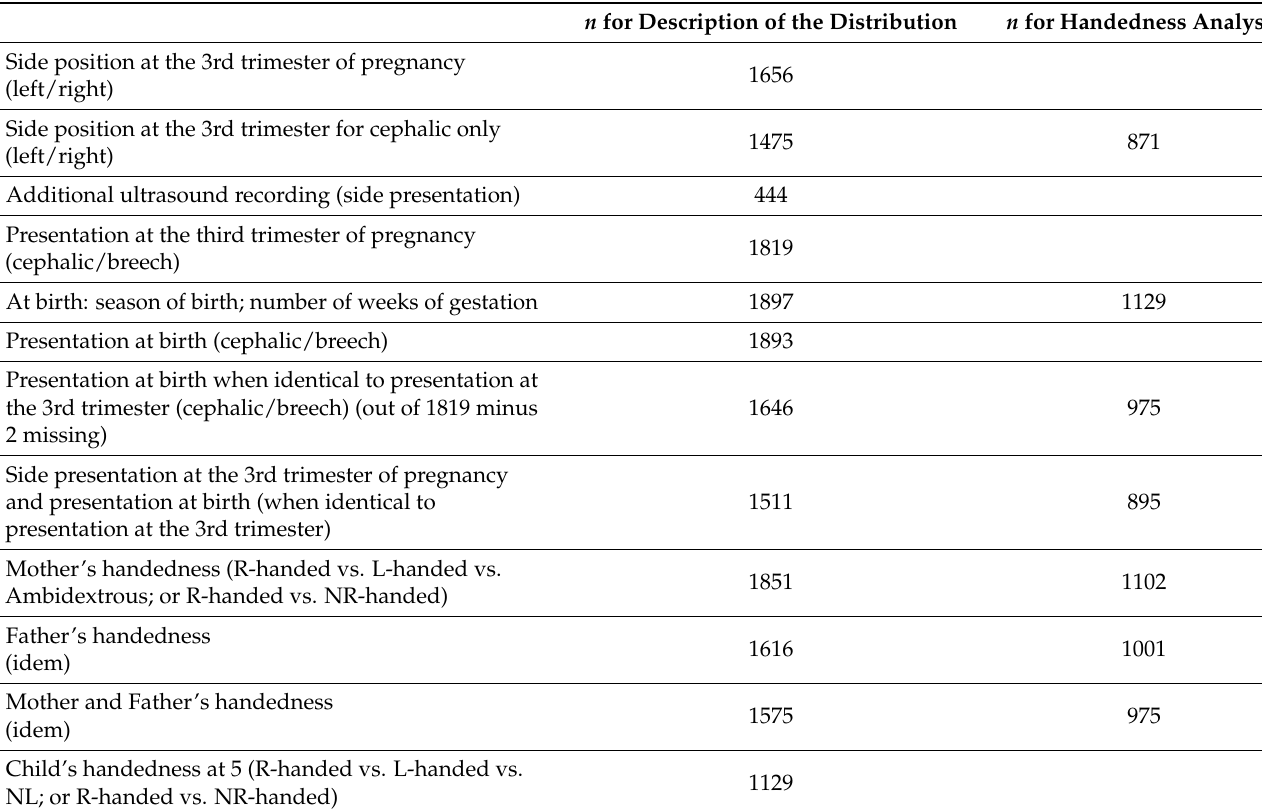
Table 1. Number of children considered for the analyses. n for Description of the Distribution n for Handedness